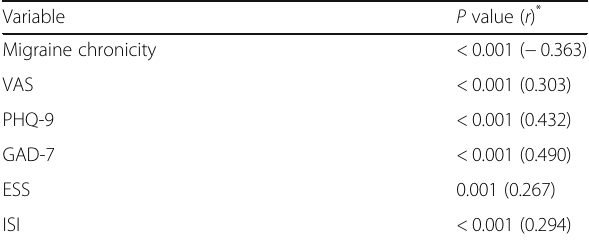
Table 3 Factors associated with the overall AQ score by univariate analyses in migraine patients